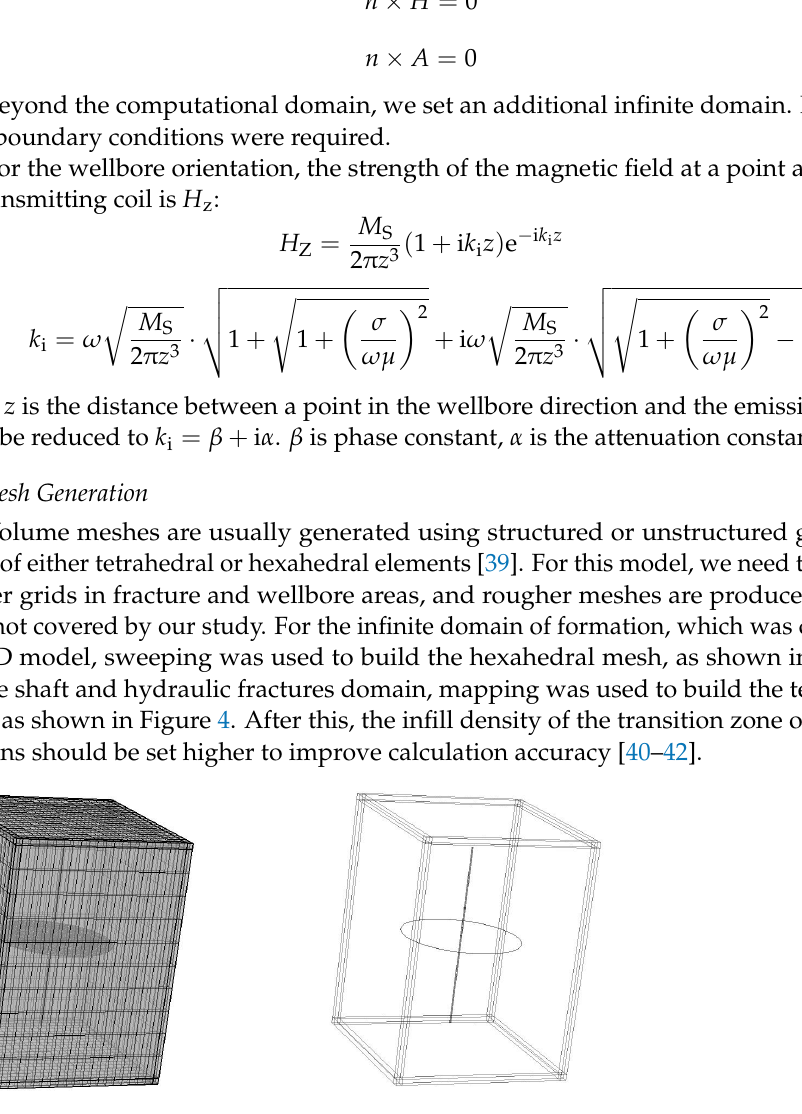
Figure 4. Meshing diagram of the shaft and hydraulic fracture (tetrahedral mesh). 3. Validation Experiments 3.1. Electromagnetic Signal Response Analysis The purpose of establishing the forward mode of electromagnetic monitoring is to obtain the electromagnetic signal in different support layer cases, and according to the obtained different signal data, obtain the law between fracture parameters and electro- magnetic signals. Firstly, we set an example to contrast the data on whether the fractures were filled with magnetic proppant. This example confirmed the feasibility of the pro- posed design and verified the sensitivity of the probe to changes in formation conditions. Then, we need to vary the basic model parameters, including the conductivity of the back- ground formation, the conductivity of the proppant, and emission frequency.